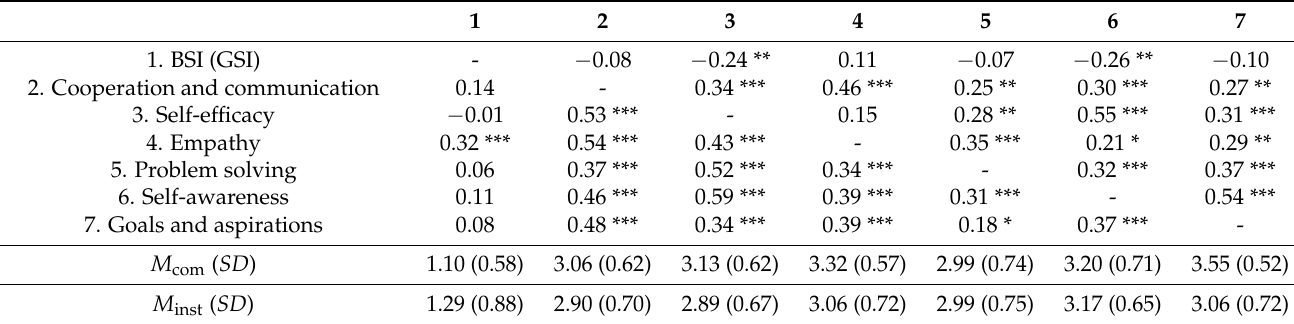
Table 2. Indexes of correlations between psychopathological symptoms (BSI (GSI)) and resilience (HKRAM) and descriptive statistics by group (adolescents in the community and institutionalised adolescents).